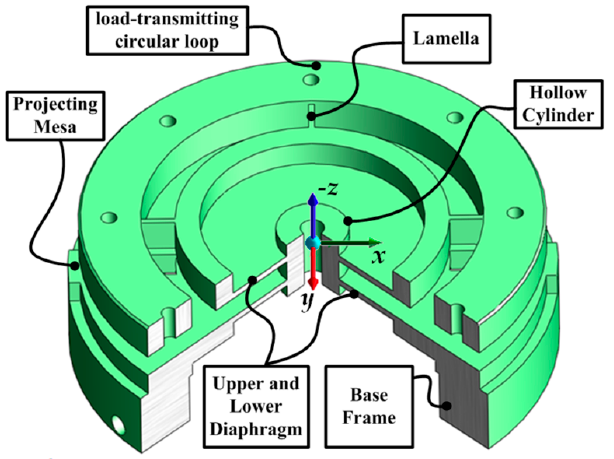
Figure 4. 3D model of the monolithic EE structure.